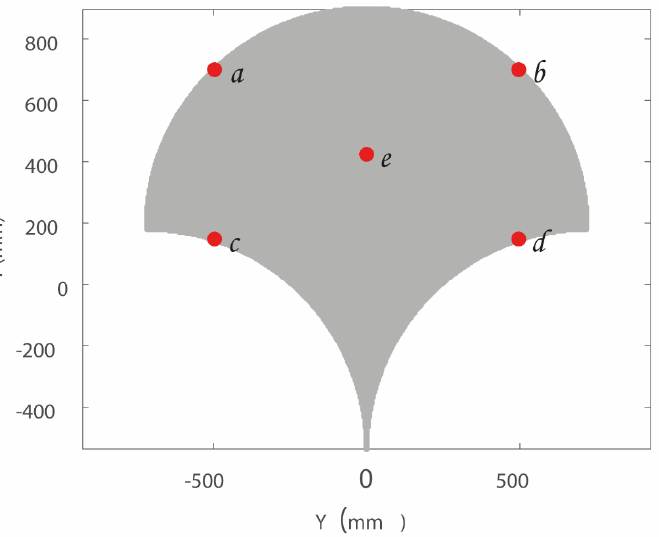
Figure 7. Five critical positions ( a ( − 496, 700), b (496, 700), c ( − 496, 148), d (496, 148), e (0, 424)) within the NURSE